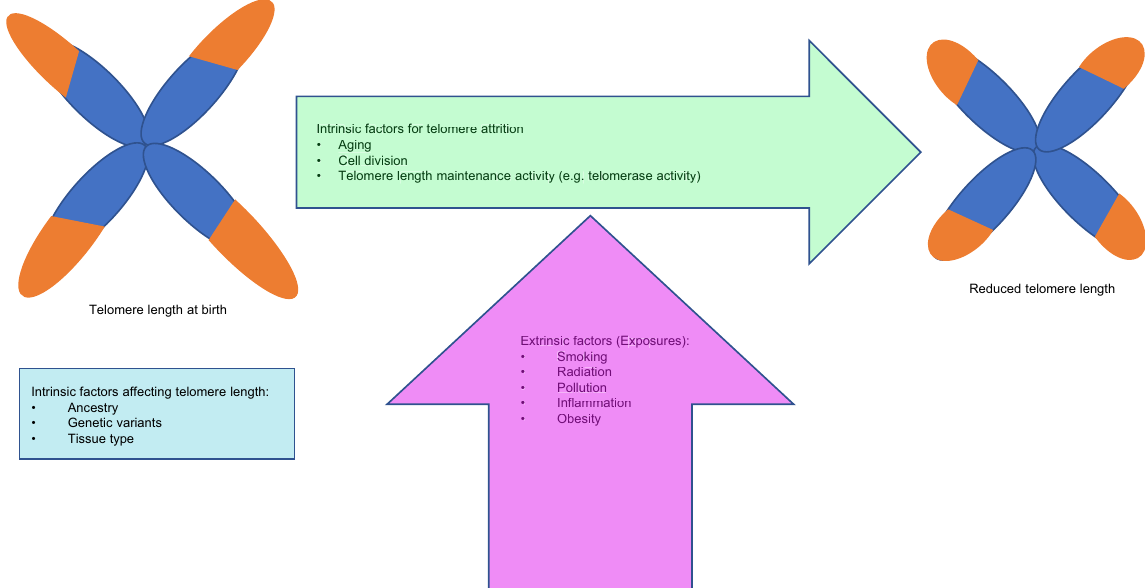
Fig. 3 Factors in fl uencing telomere length and attrition. Schema showing how intrinsic factors such as genetic variants in fl uence telomere length and the in fl uence of exposures and intrinsic factors like age, on telomere attrition.